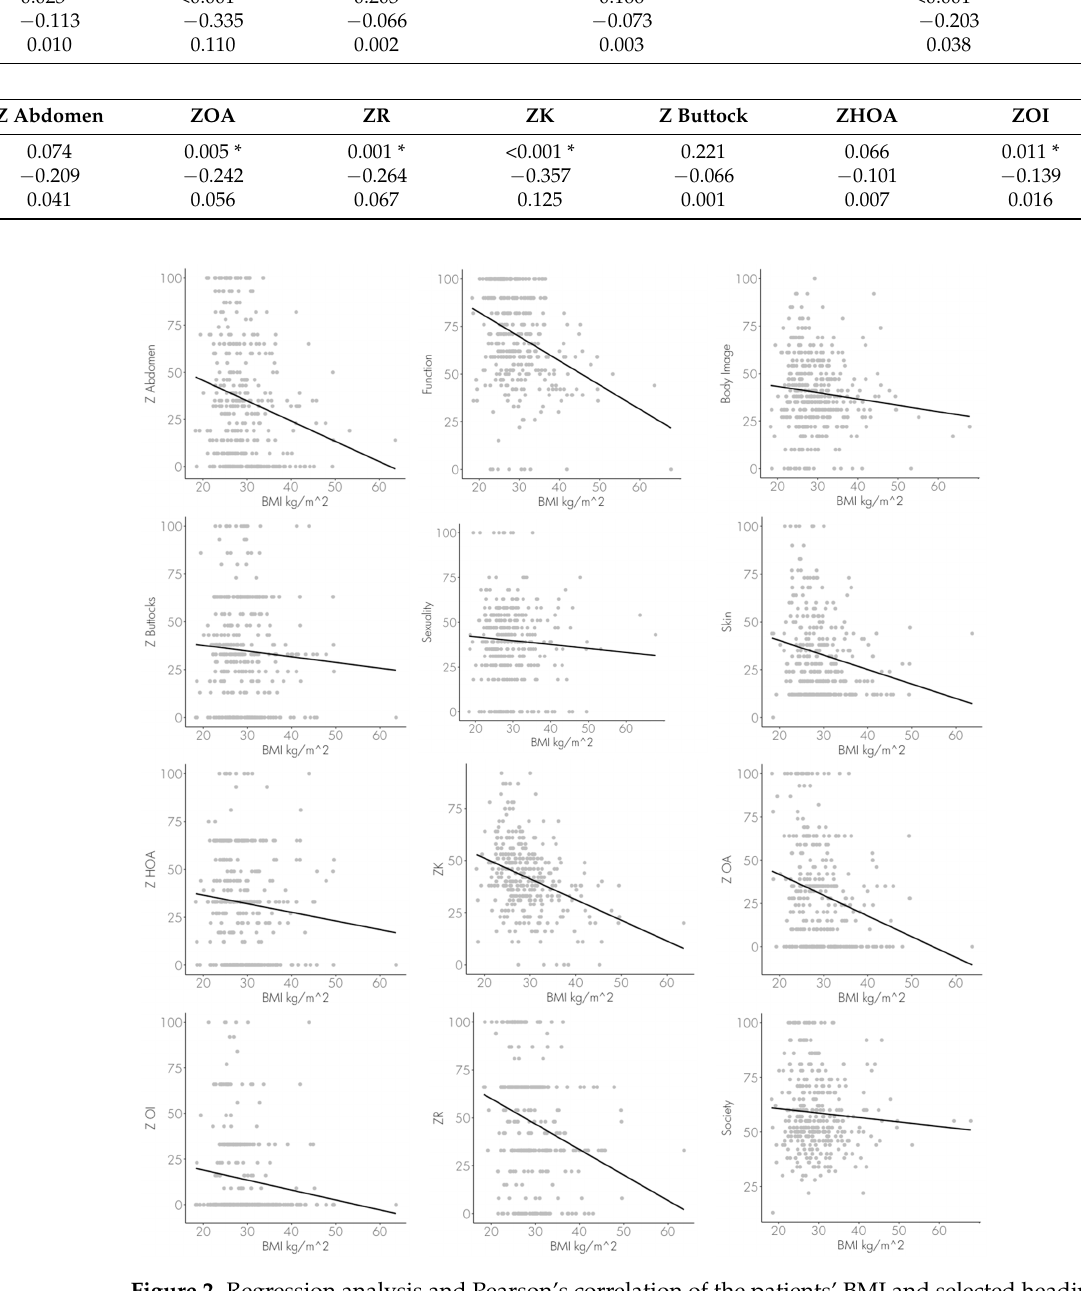
Figure 2. Regression analysis and Pearson’s correlation of the patients’ BMI and selected headings of the BODY-Q questionnaire: body image, sexuality, society, satisfaction-abdomen (Z Abdomen), satisfaction-body (ZK), satisfaction-upper arms (ZOA), satisfaction-back (ZR), satisfaction-buttocks (Z Buttock), satisfaction-hips and outer thighs (ZHOA), satisfaction-inner thighs (ZOI), assessment of excess skin (Skin).